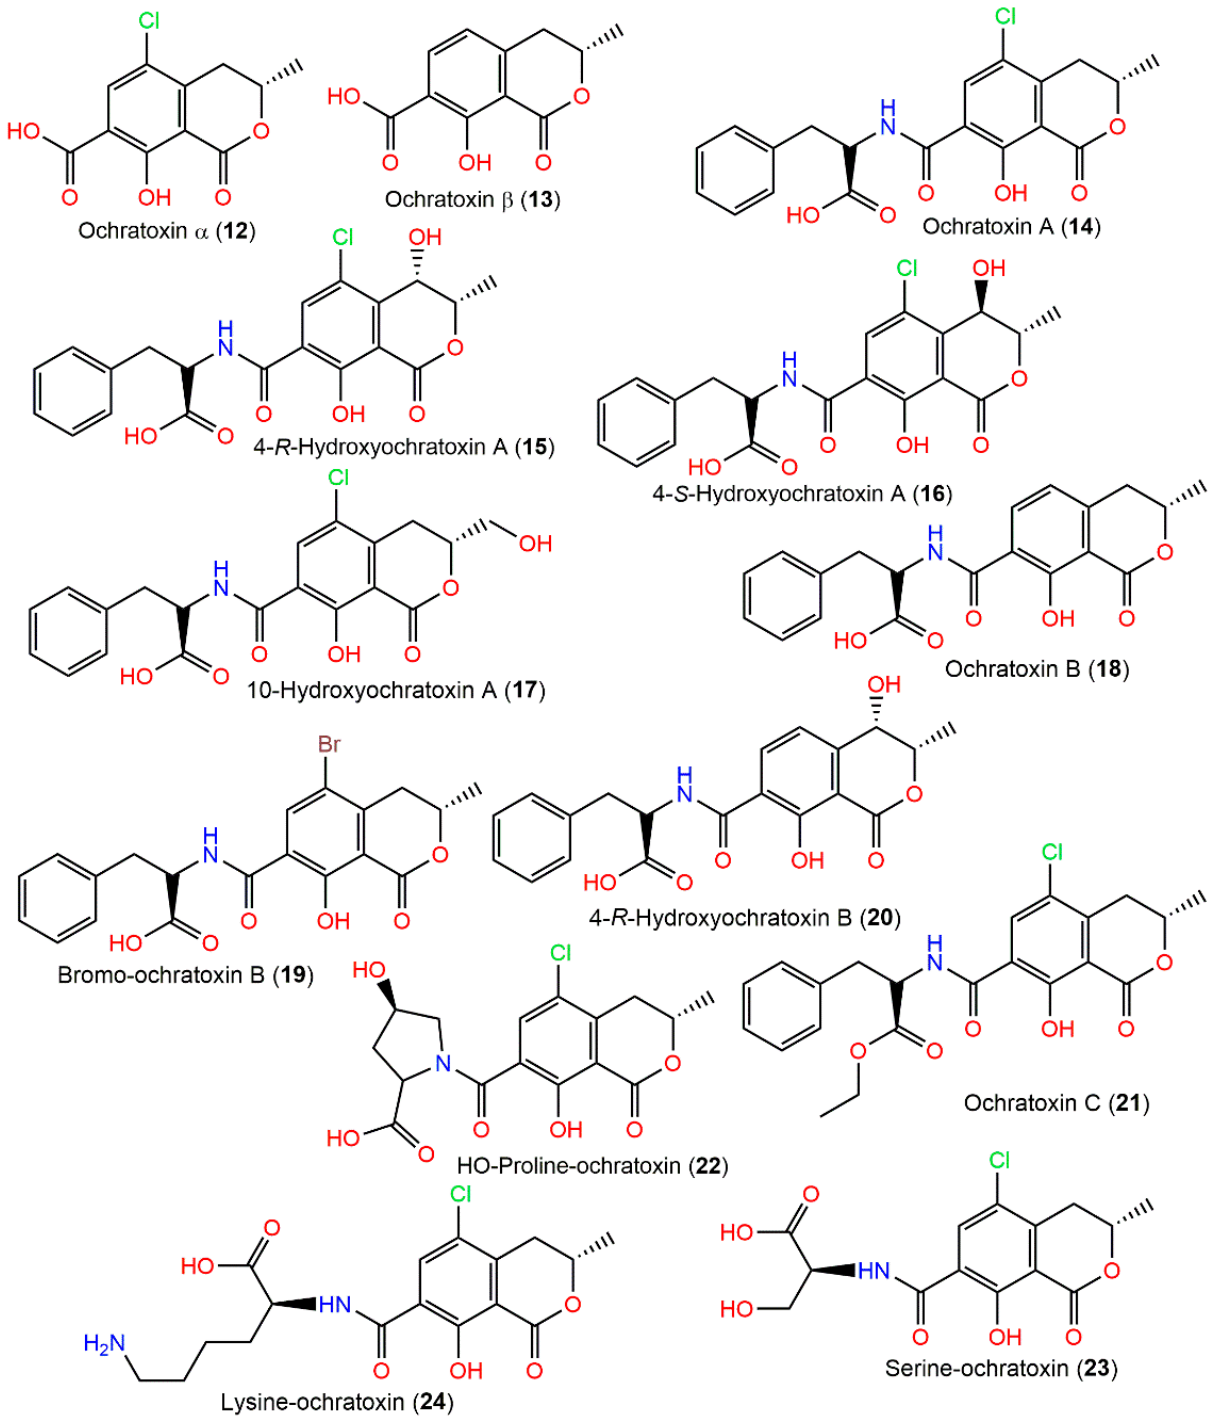
Figure 2. Isocoumarin derivatives ( 12 – 24 ) reported from A. ochraceus.